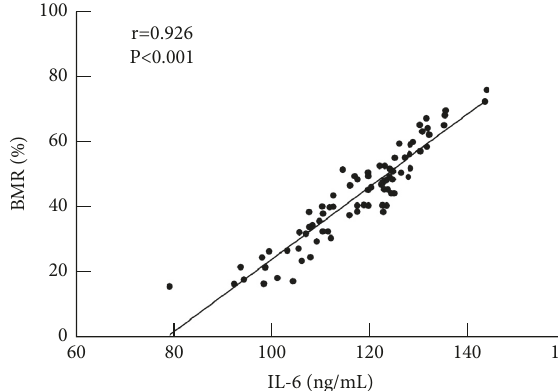
Figure 5: Scatter plot of correlation between the serum IL-6 level and BMR in